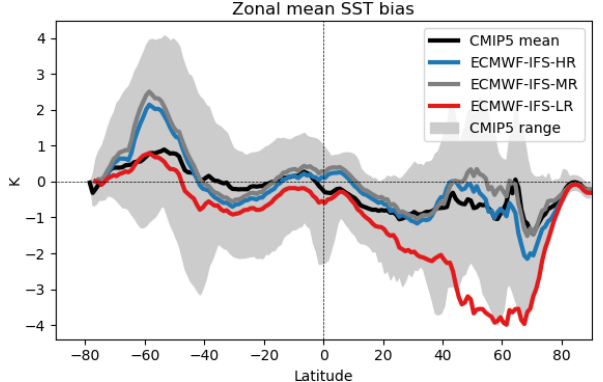
Figure 21. Zonal mean SST biases relative to EN4 (Good et al., 2013) for the period 1986–2005 from ECMWF-IFS (experiment hist-1950) and CMIP5 models (experiment